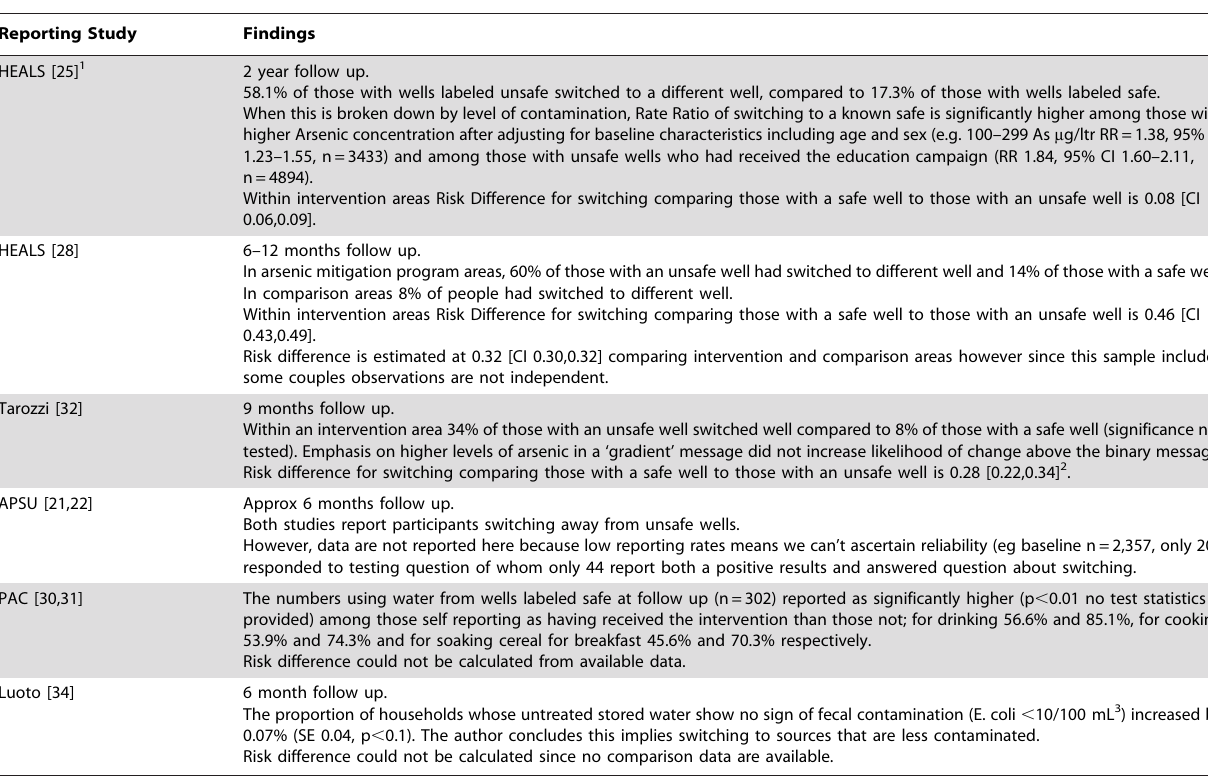
Table 3. Impact on Switching to Safer Water Sources.